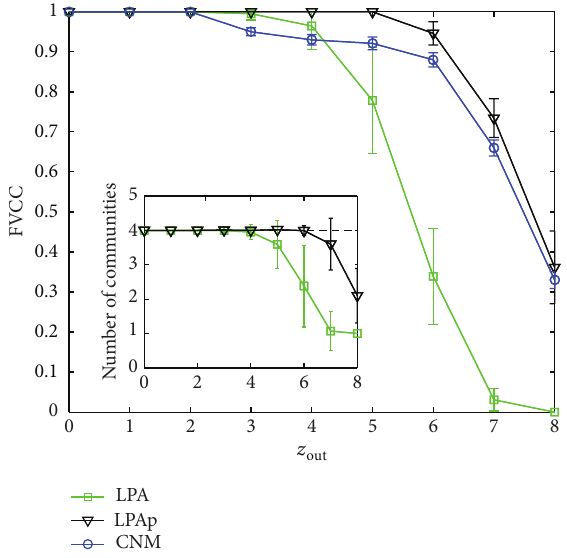
Figure 6: FVCC of CNM, LPA, and LPAp on unweighted computer- generated